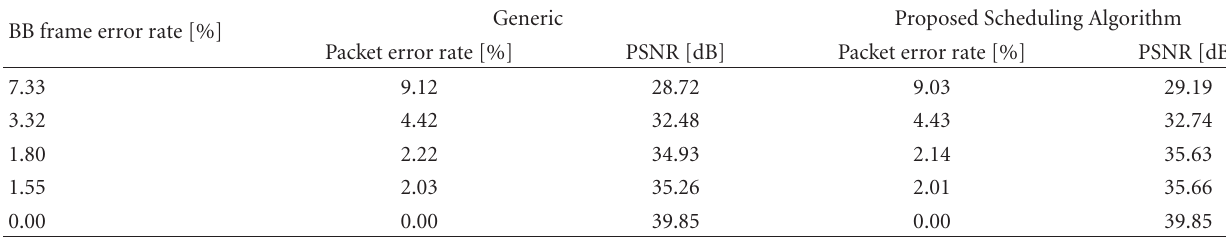
Table 5: PSNR and Packet error rate